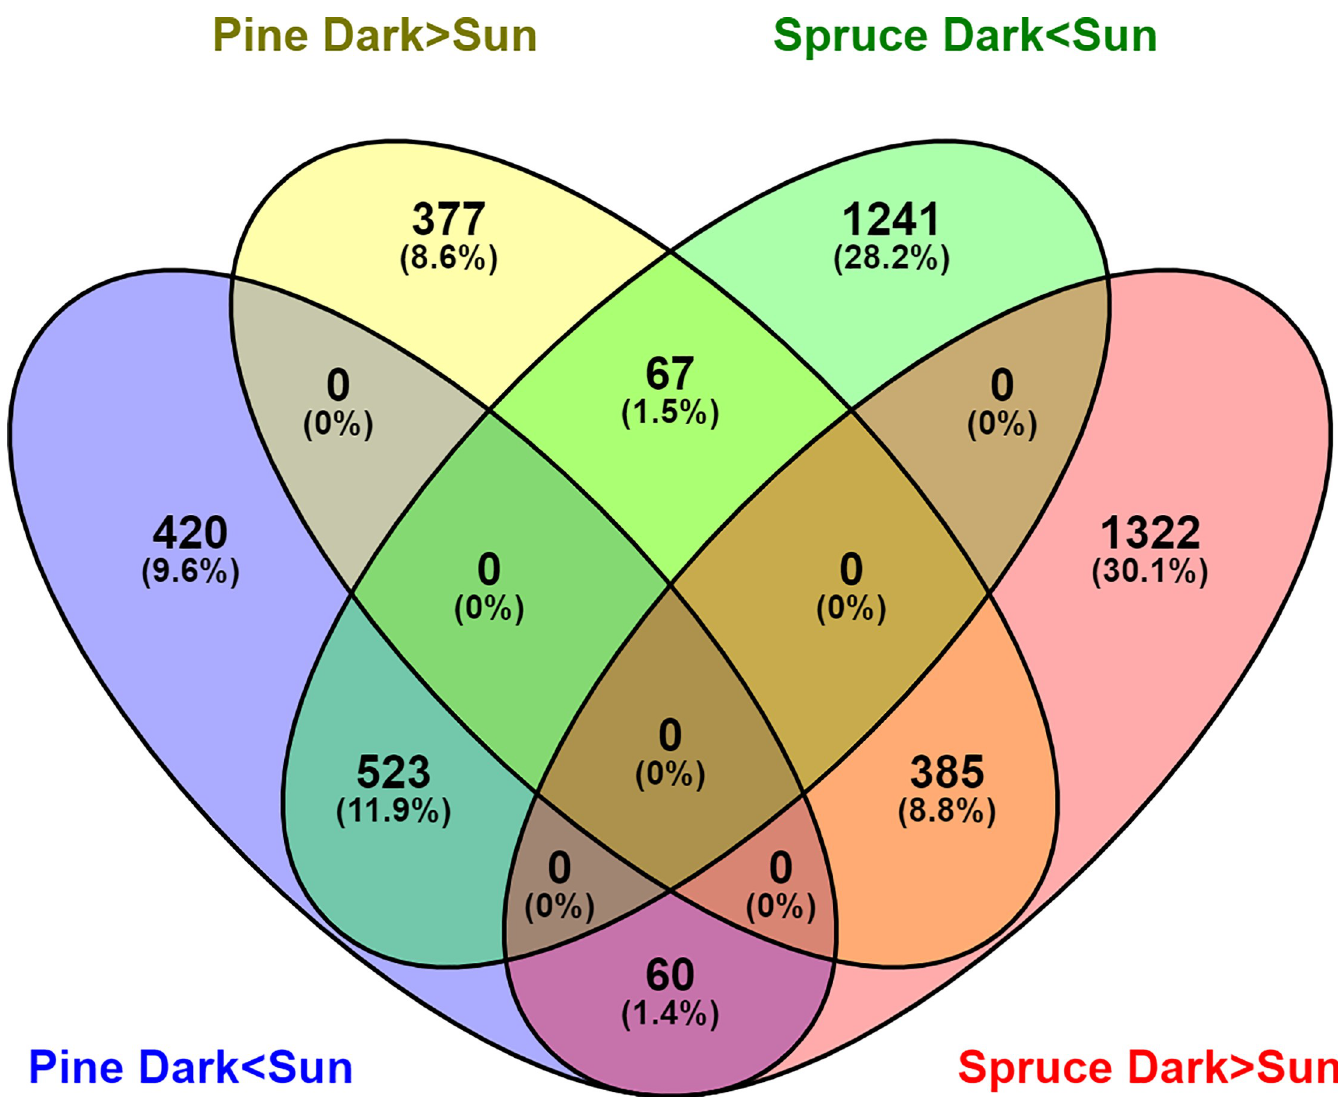
Fig 3. Venn diagram of the differentially expressed genes under DARK and SUN in Scots pine and Norway spruce.